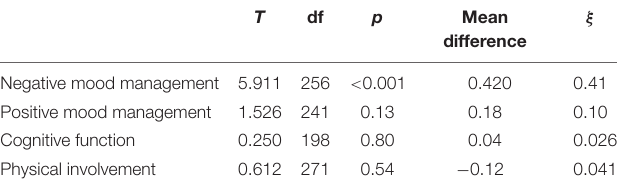
TABLE 2 | Yuen’s t -test for groups for the four factors. T df p